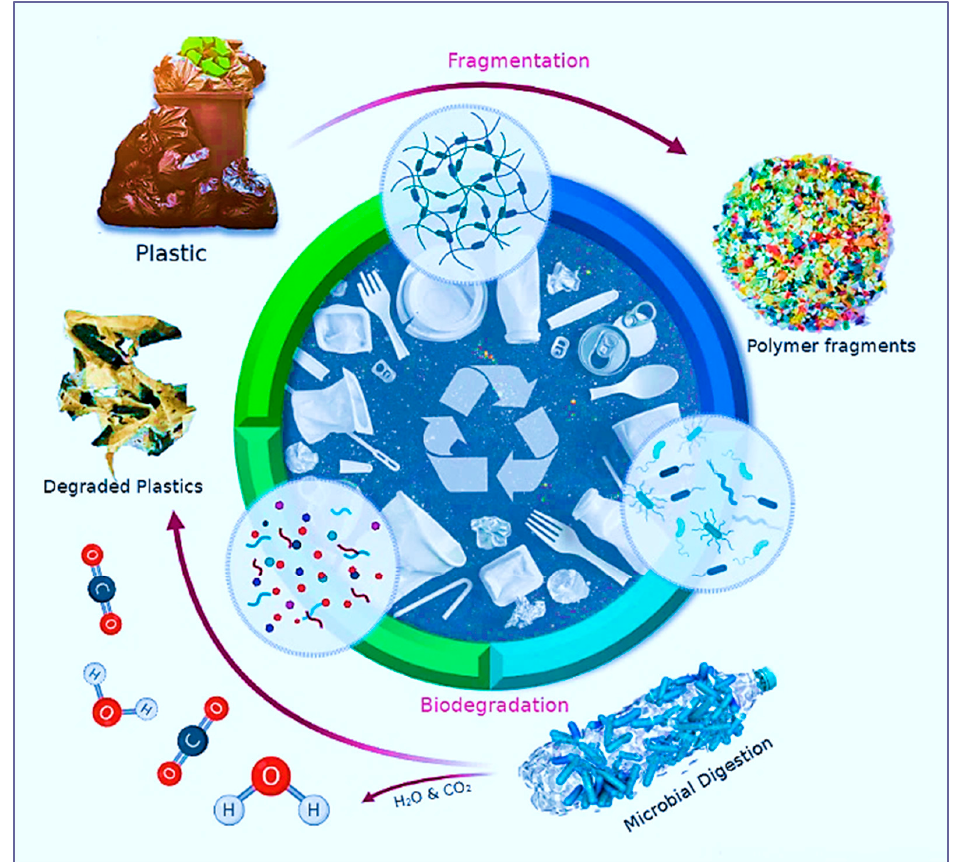
Figure 3. Schematic representation of fragmentation and biodegradation process.